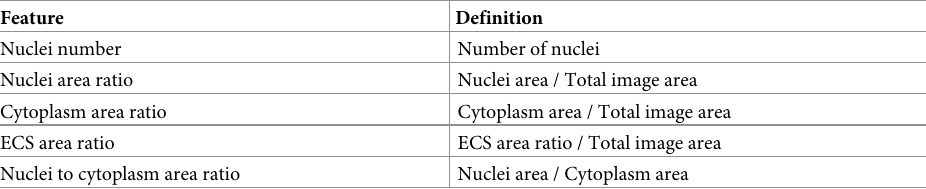
Table 6. Feature set of HE-stained meningioma pathology images.